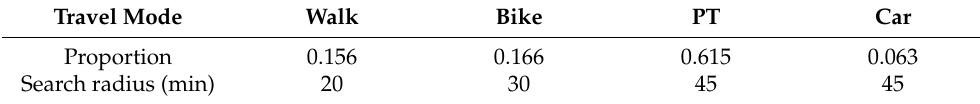
Table 2. Proportions and search radii of different travel modes used by high school students.